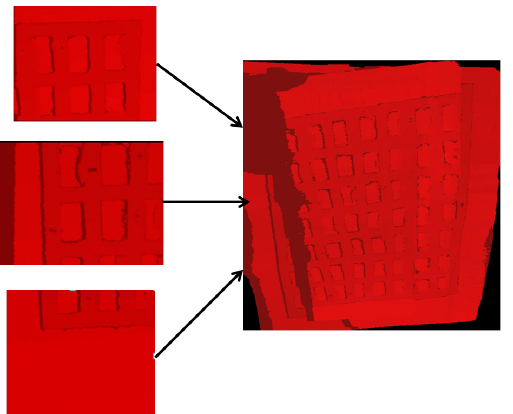
Figure 12. Stitching the drone’s depth footage recorded in the lab